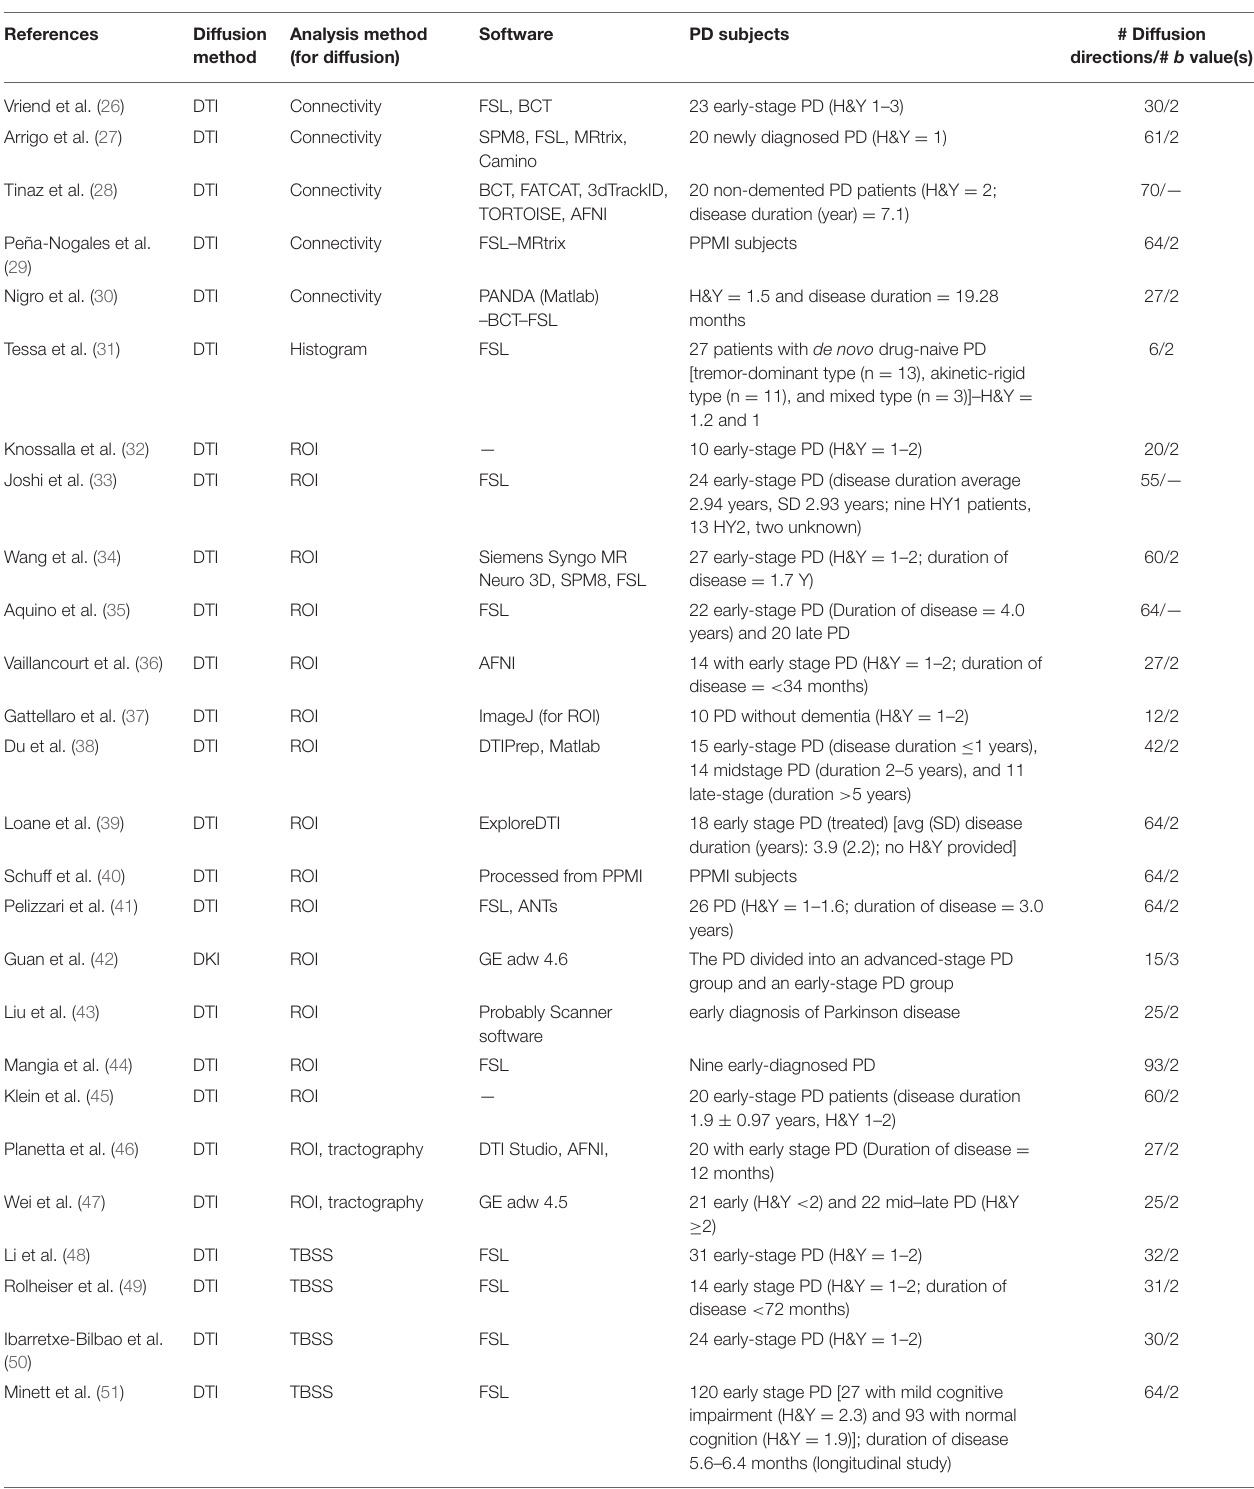
TABLE 1 | Summary of diffusion studies in early-stage